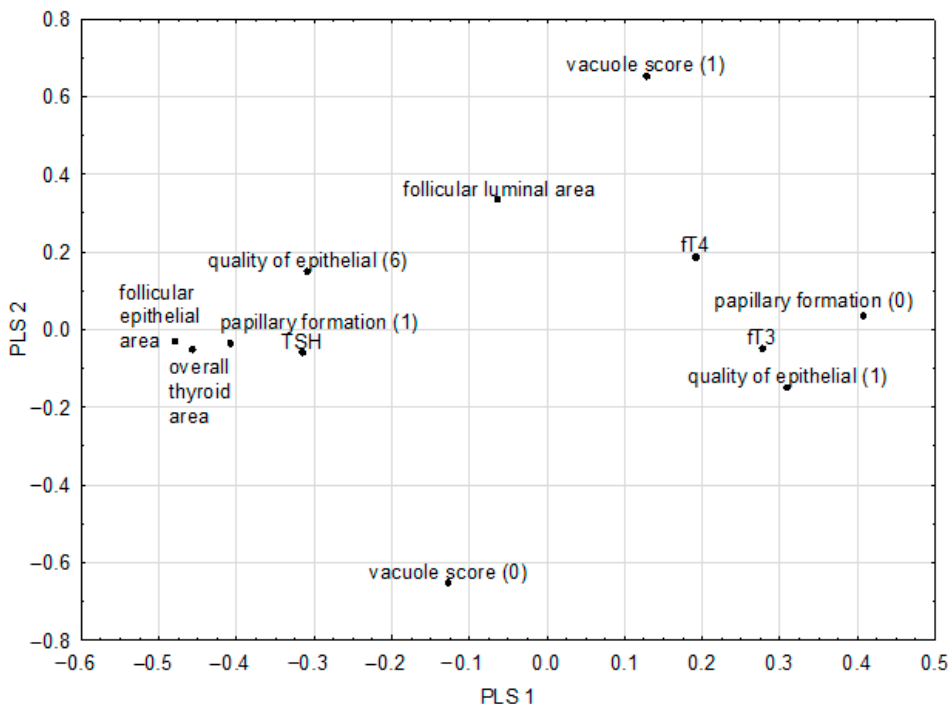
Figure 6. Loadings for the first two latent components of the PLS model (quality of epithelial cells: (1) flattened or (6) cuboidal; papillary formation: formation (1) or lack of papillary formation (0); vacuole score: observed (1) or lack of vacuole (0)).